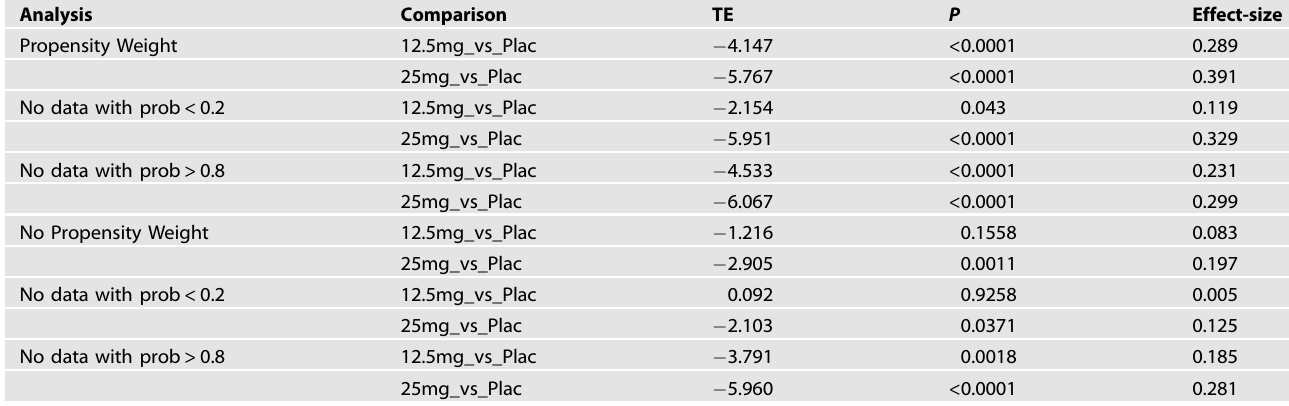
Table 2. Sensitivity analysis results to evaluate the impact of the excessively high and excessively low propensity to a placebo effect on the estimated TE with and without a propensity weigh in the MMRM analysis.